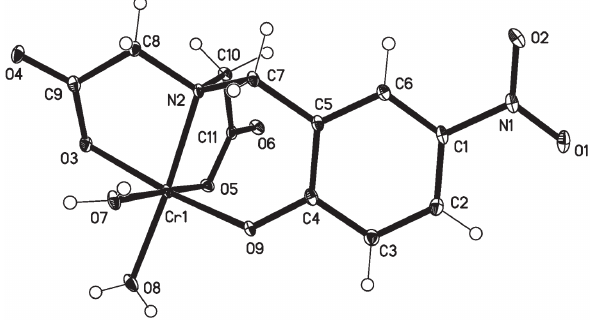
Table 1: Data collection and handling.